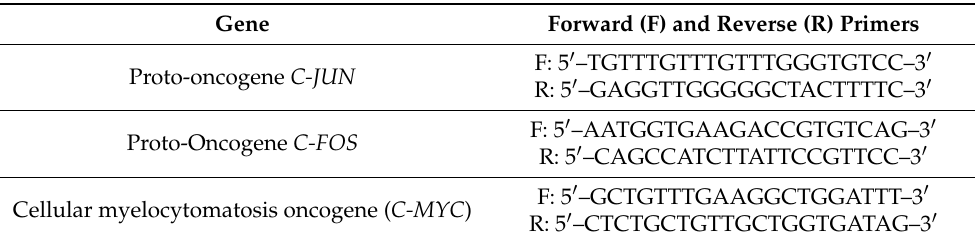
Table 1. Primer sequences of genes evaluated after the FLIPUS